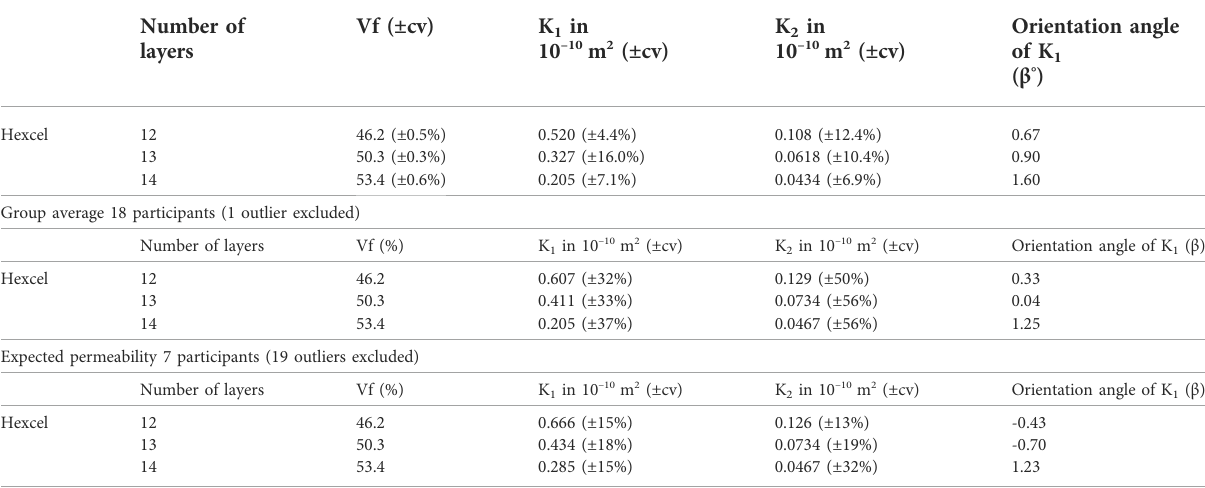
TABLE 2 Obtained K 1 and K 2 permeability directions and orientation angle of K 1 for the measurements performed, average of the 18 participants and the expected permeability after removing all outlier measurements.